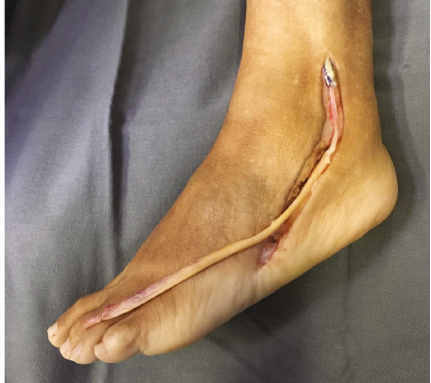
Figure 6: Patient II: aspect of the STA after proximal fi xation. We have used the STA in its full length to ensure that there was adequate distal stump length remaining to fi x it to the base of the fi fth metatarsal.